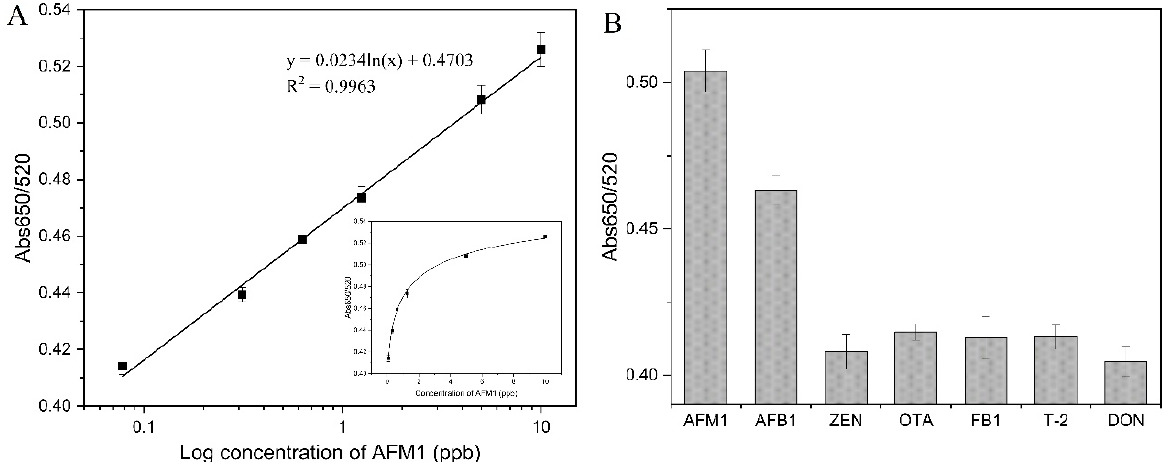
Figure 6. ( A ) Standard curve of the aptamer-AuNPs colorimetric method for detection of AFM1. ( B ) Specificity of aptamer-AuNPs colorimetric method for detection of AFM1.